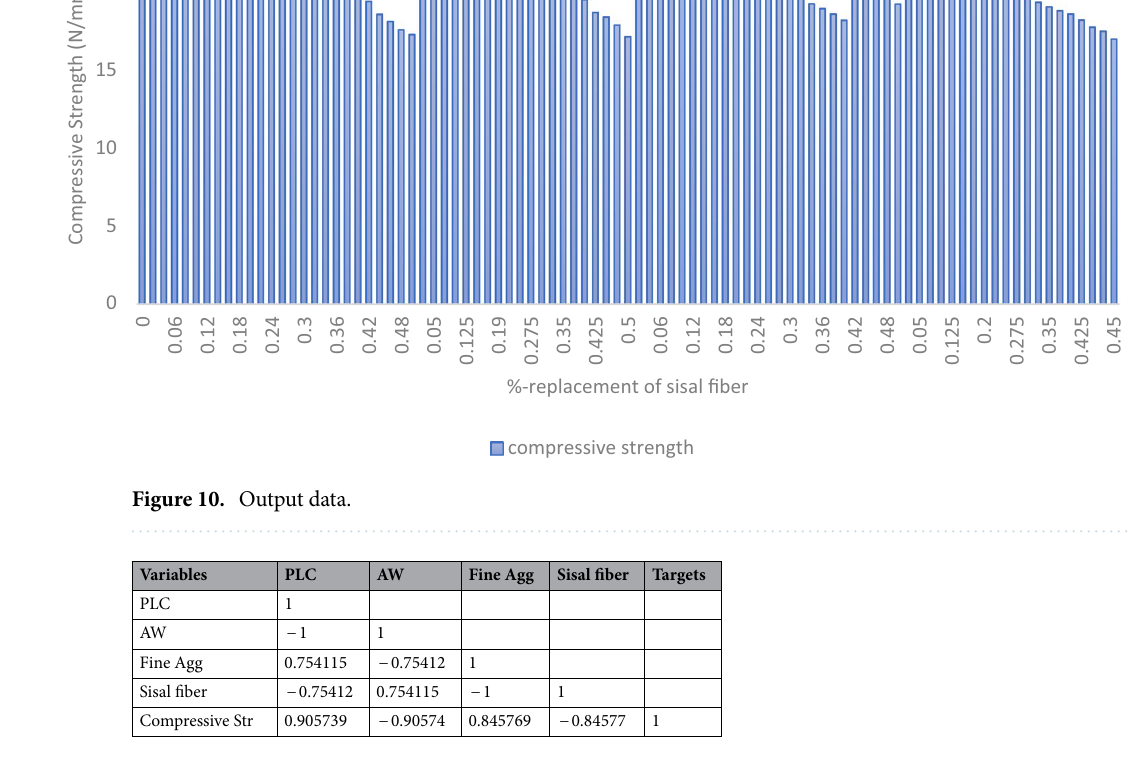
Table 4. Correlation statistical results of ANFIS model variables.